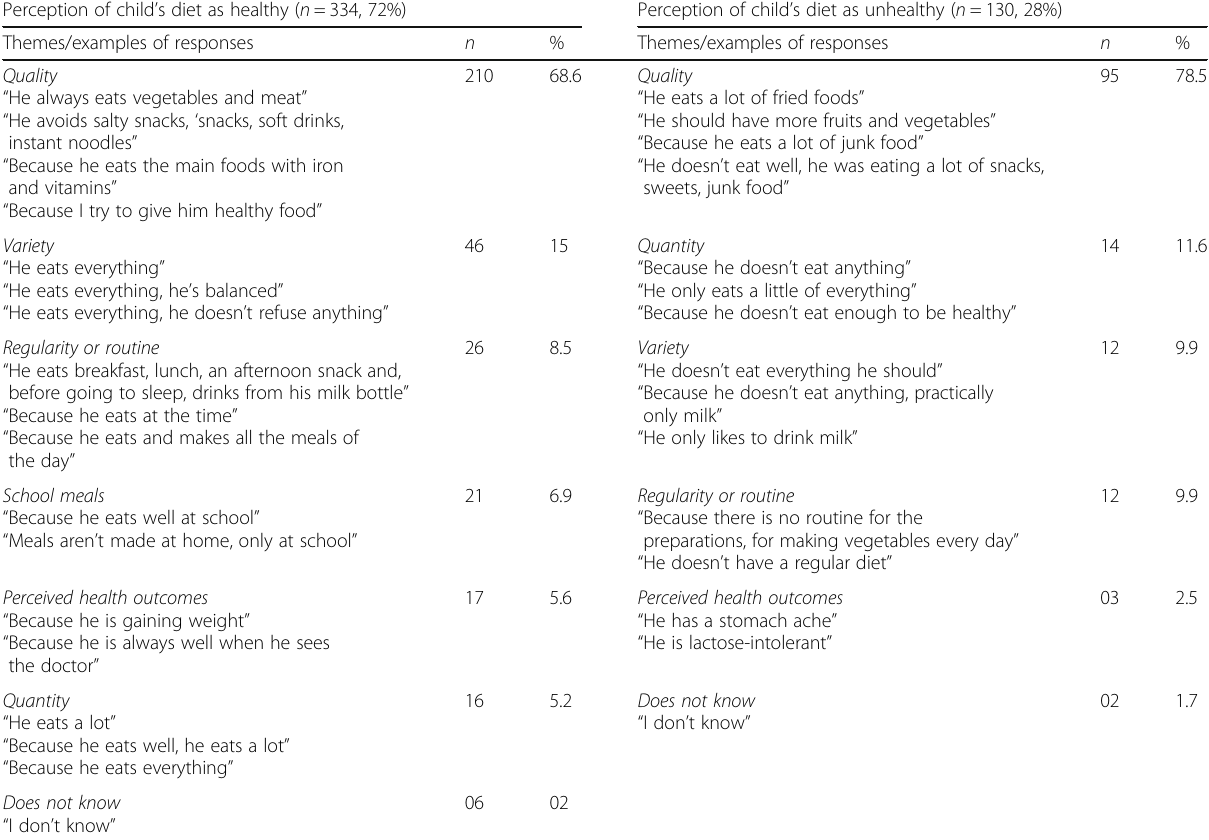
Table 2 Categorization and distribution of responses regarding mothers ’ perceptions of their children ’ s diets ( n = 464) Perception of child ’ s diet as healthy ( n = 334,